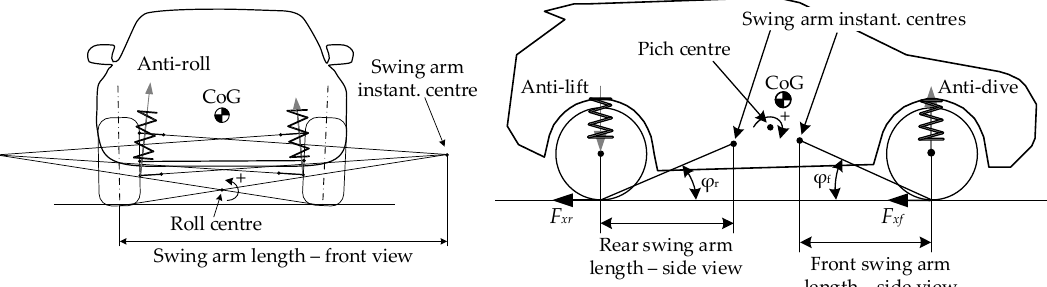
Figure 4. Front and side views of the experimentally validated vehicle model. The grey arrows represent the anti-roll and anti-dive / lift force generated by in-wheel motor (IWM) torque control to suppress the roll and pitch motion,